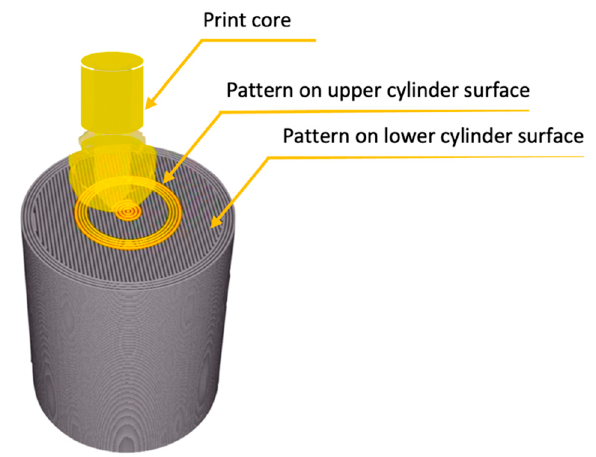
Figure 3. The path of filament application through the Print core, the scheme shows the application of the first layer of the upper cylinder; image obtained in Cura software (Layer